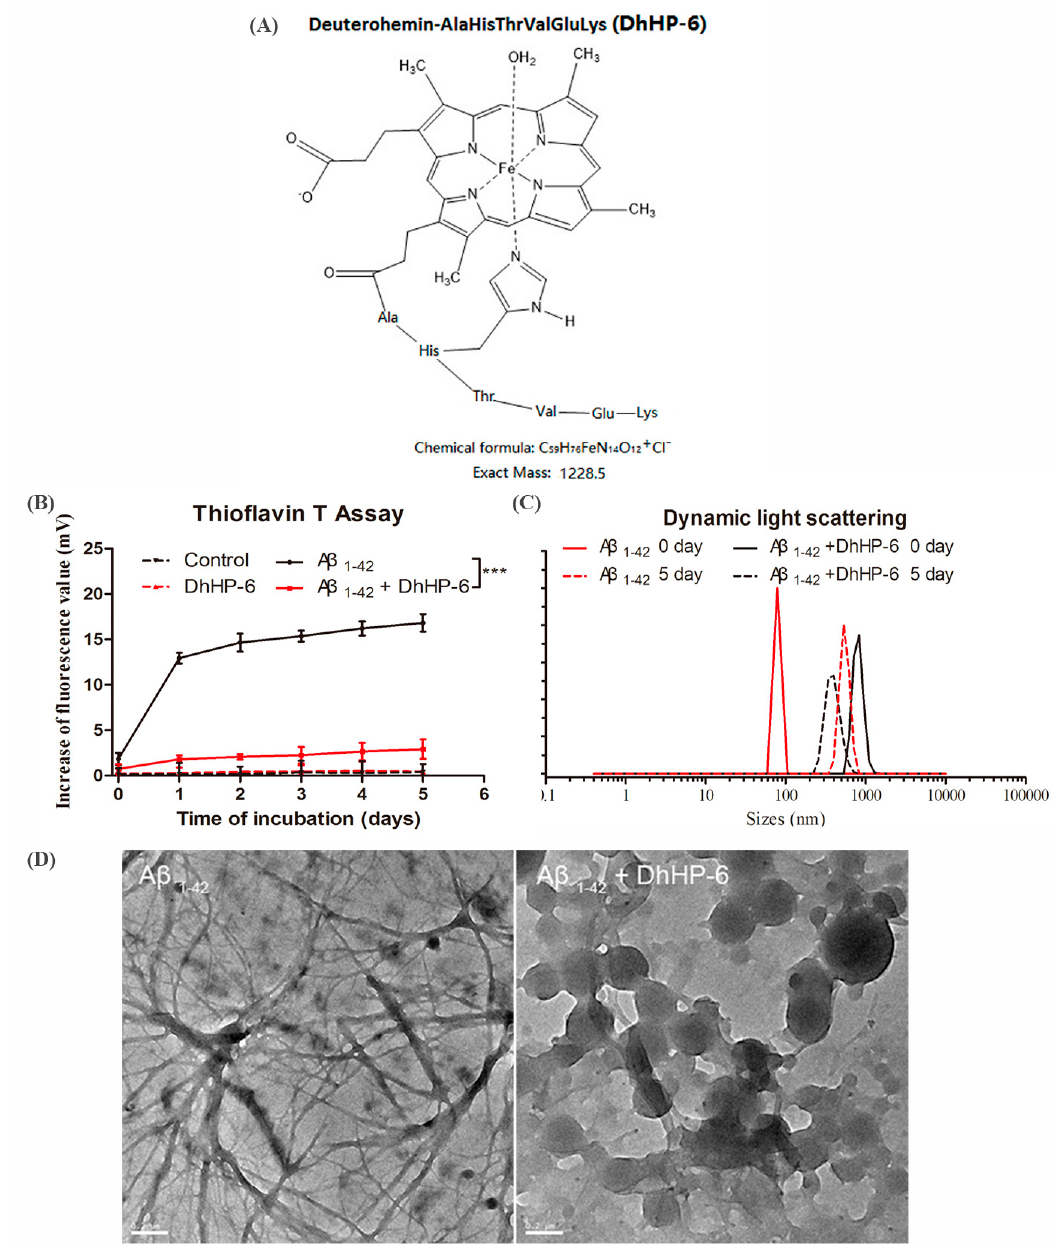
Figure 1. Molecular structure of deuterohemin-AlaHisThrValGluLys (DhHP-6) and its inhibitory effect on amyloid β (A β )1-42 aggregation in vitro. ( A ) Molecular structure of the peroxidase mimetic Deuterohemin-AlaHisThrValGluLys (DhHP-6). ( B ) Thioflavin T (Th-T) assay evaluated the aggregation of A β 1-42 (10 μ M, black line) and A β 1-42 incubated with DhHP-6 (10 μ M:10 μ M molar ratio, red line) at 37 °C for five days (*** p < 0.001). ( C ) Particle size analysis of pure A β 1-42 (10 μ M; day 0: black line, day 5: dashed black line) and A β 1-42 incubated with DhHP-6 (10 μ M:10 μ M molar ratio; day 0: red line, day 5: dashed red line) at 37 °C from day 0 to 5 by dynamic light scattering (DLS) assay. ( D ) Characterization of A β 1-42 (10 μ M) and A β 1-42 incubated with DhHP-6 (10 μ M:10 μ M molar ratio) at 37 °C for three days by TEM observation, scale bar = 0.2 μ m. The cytotoxic and neuroprotective effects of DhHP-6 in HT22 mouse hippocampal neuron cells and SH-SY5Y human neuroblastoma cells were also evaluated by the 3-[4,5-dimethylthiazol-2-yl]- 2,5-diphenyl tetrazolium bromide (MTT) cell viability assays. DhHP-6 was non-toxic to HT22 and